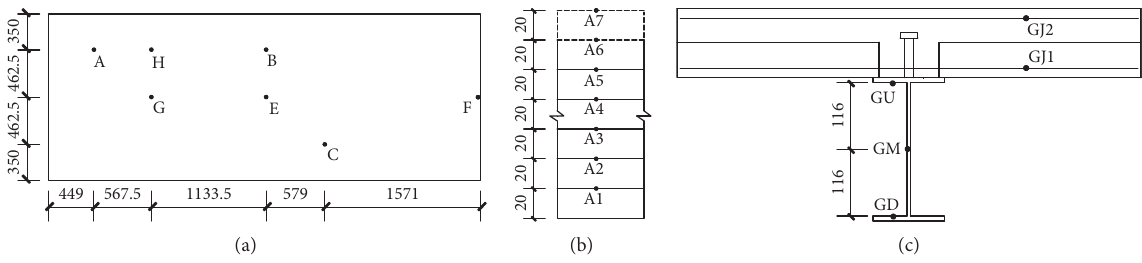
Figure 3: Temperature measurement positions: (a) plan arrangement, (b) measurement positions for concrete, and (c) measurement positions for rebars and steel beams.